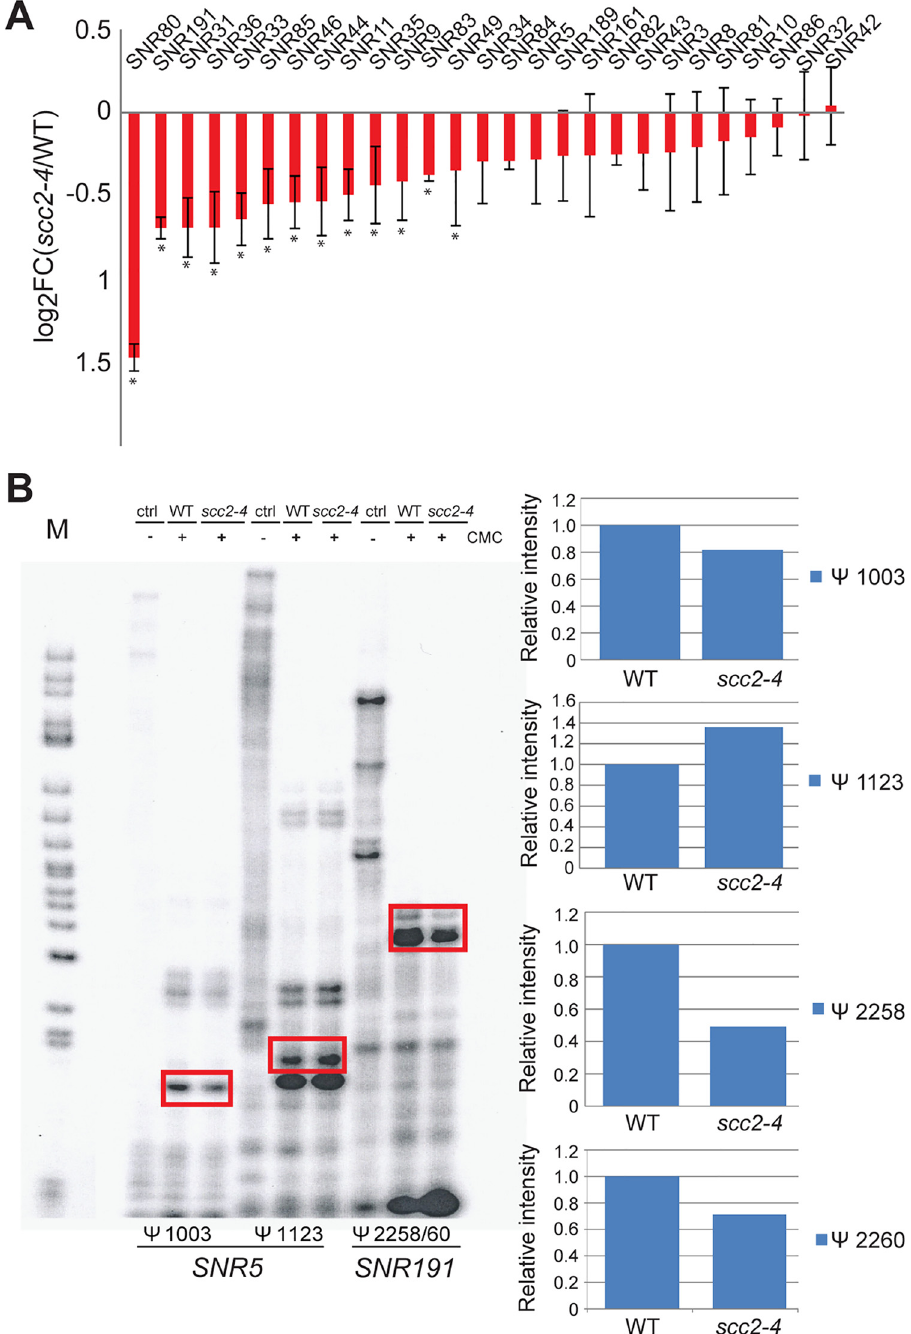
Fig 6. Pseudouridylation of rRNA is reduced in the scc2-4 mutant. (A) The Box H/ACA snoRNAs that guide sequence-specific pseudouridylation are down-regulated in the scc2-4 mutant. The error bars represent the standard deviation from triplicate samples and the asterisks indicate statistical significance at an adj p < 0.05. (B) Reverse transcription with primers corresponding to residues Ψ 1003 and Ψ 1123 for SNR5 and residues Ψ 2258 and Ψ 2260 for SNR191 was performed. Samples were treated with or without CMC, exposed to pH 10.4 for 4 hrs and reverse transcribed. The rectangles indicate the bands quantified to the right. Pseudouridylation assays were performed at least two times; a representative experiment is